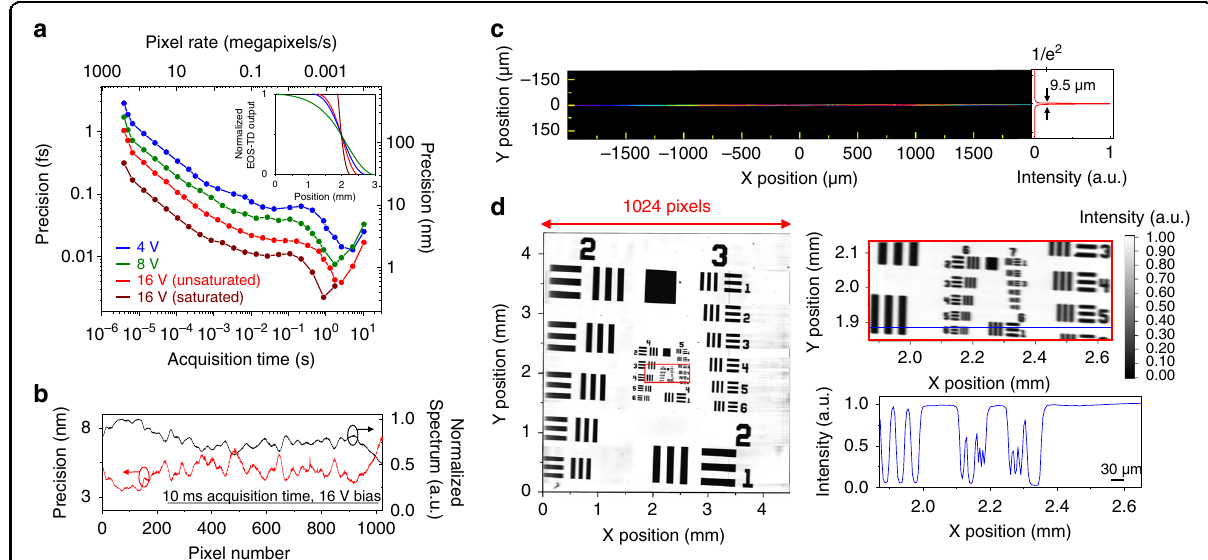
Fig. 2 Axial and lateral resolution analysis of the line-scan TOF method. a TOF precision measurement in terms of overlapping Allan deviation as a function of acquisition time. Three MUTC-photodiode bias voltages of 4, 8 and 16 V (unsaturated and saturated camera conditions) are demonstrated. Inset: The normalized EOS-TD outputs with respect to the relative timing between the optical pulses and the rising edges of photocurrent pulses show that the measurable ranges of 4, 8 and 16 V (unsaturated) and 16 V (saturated) bias voltages are 3 mm, 1.6 mm, 1.2 mm and 0.4 mm, respectively. b TOF precision measurement at each pixel position at 10 ms acquisition time (16 V bias, unsaturated camera). c Measured beam pro fi le when focused with 30-mm focal length (see Methods). d Microscopic imaging of the resolution target. The top right panel shows the magni fi ed image of groups 6 and 7 (red box of the left panel). As shown in the single line-scan trace, the three bars of Element 6 in Group 6 are decomposed with ~23% contrast, resulting in ~114 lp/mm (4.38 μ m) lateral